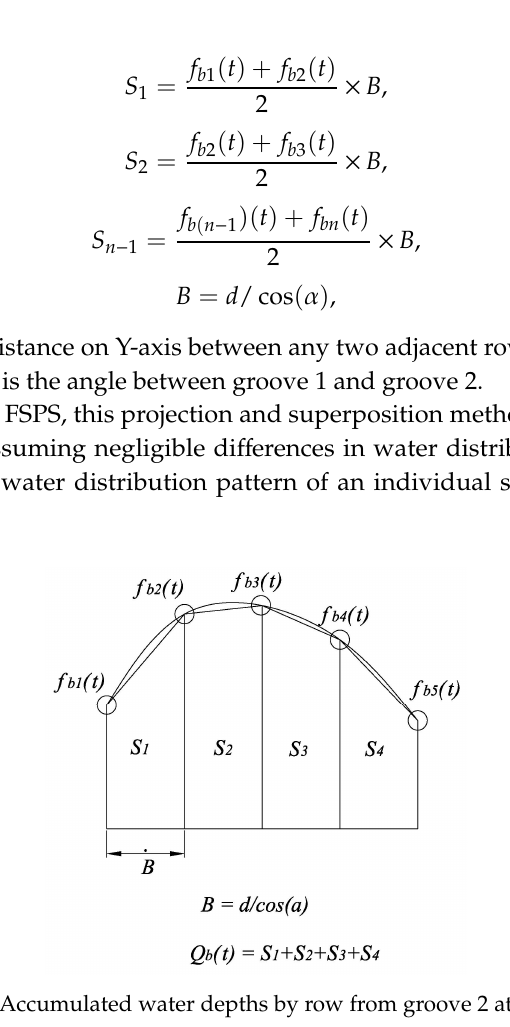
Figure 5. Accumulated water depths by row from groove 2 at point t m.